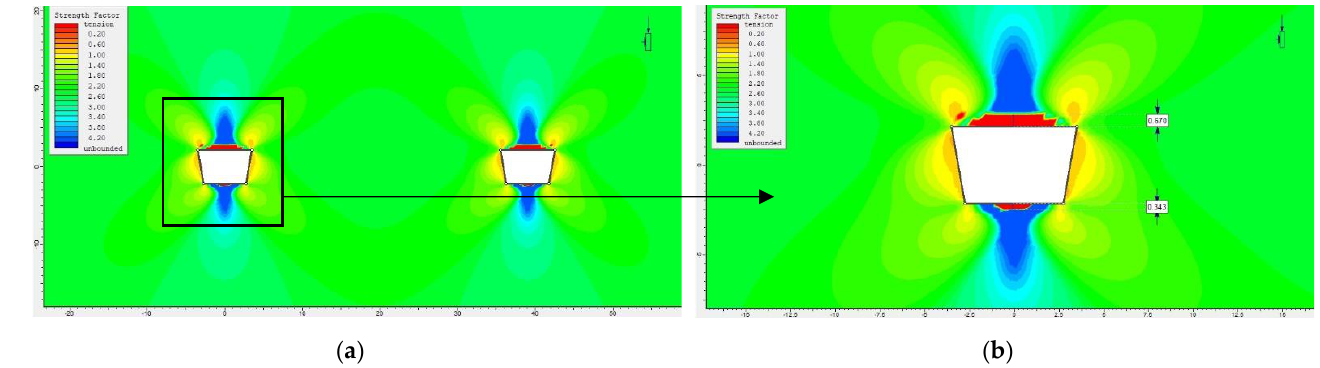
Figure 16. Distribution of strength factor values in the cross-section through ramps drilled in dolomite: ( a ) view of both headings; ( b ) close-up of a single excavation.